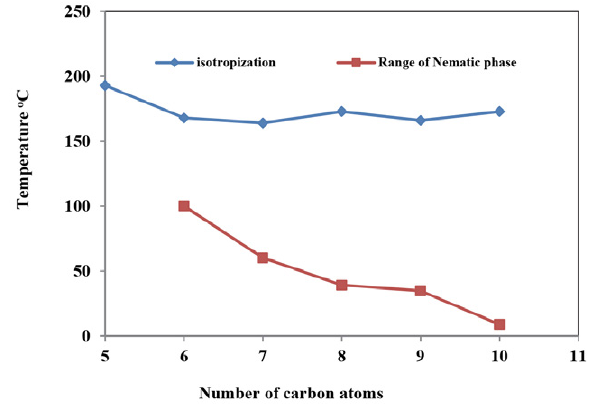
Figure 8: Relationship of isotropization and nematic phase range with the number of carbon atoms